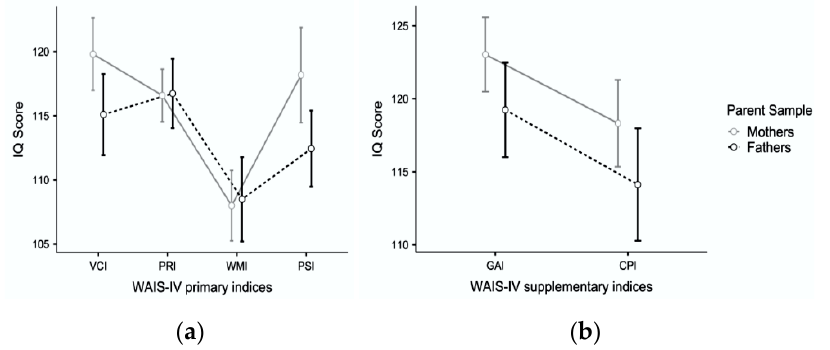
Figure 2. The cognitive profile of mothers and fathers of Moderately Gifted and Gifted children using ( a ) WAIS-IV primary indices; ( b ) WAIS-IV supplementary indices. Whiskers represent the 95% confidence interval (CI), and circles represent the average score obtained by each sample.